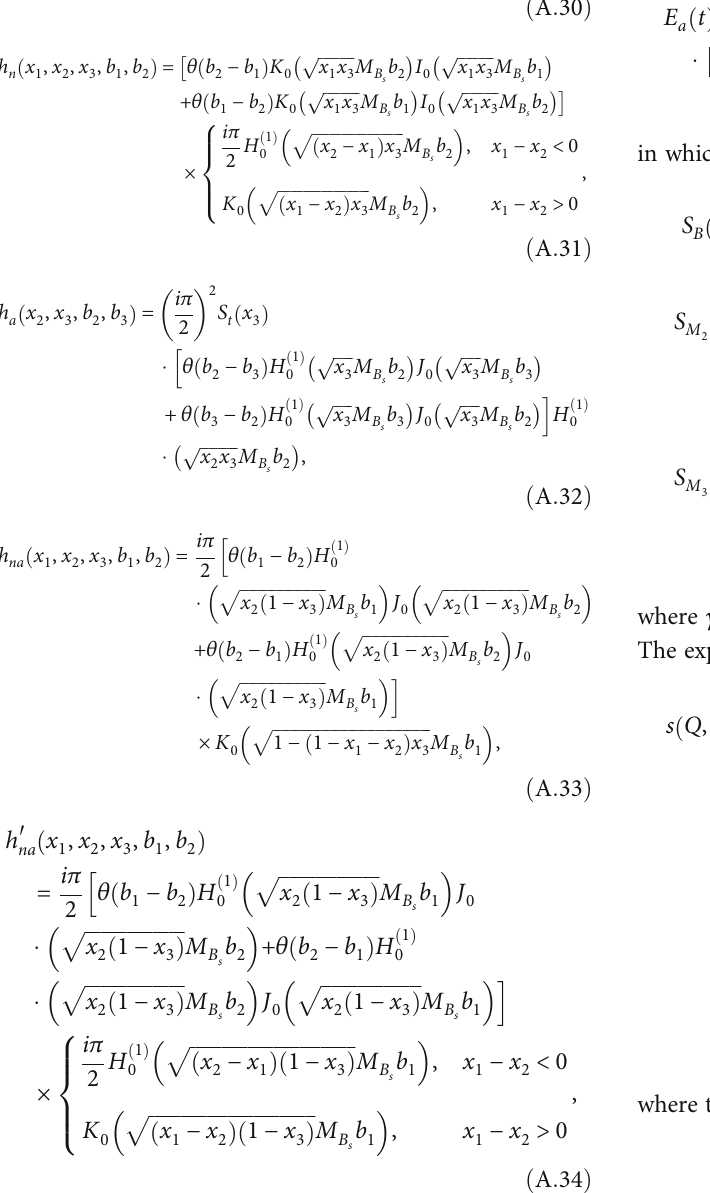
ffiffiffiffiffiffiffiffiffi p x x 1 3 p x 1 x 3 p x 1 x 3